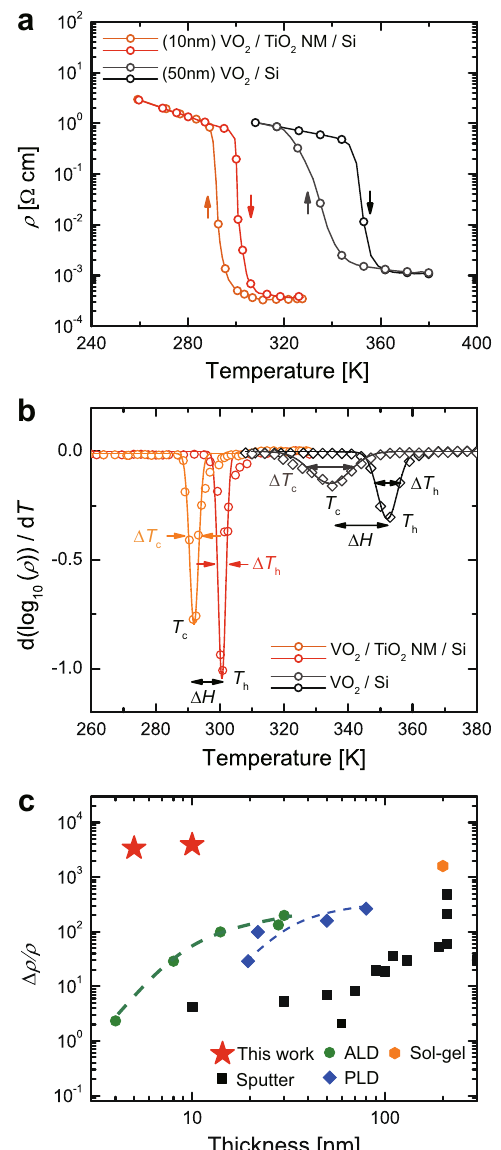
TiO 2 NM templates between VO 2 and Si enable the growth of epitaxial VO 2 fi lms with crystallographic perfection free from defects.